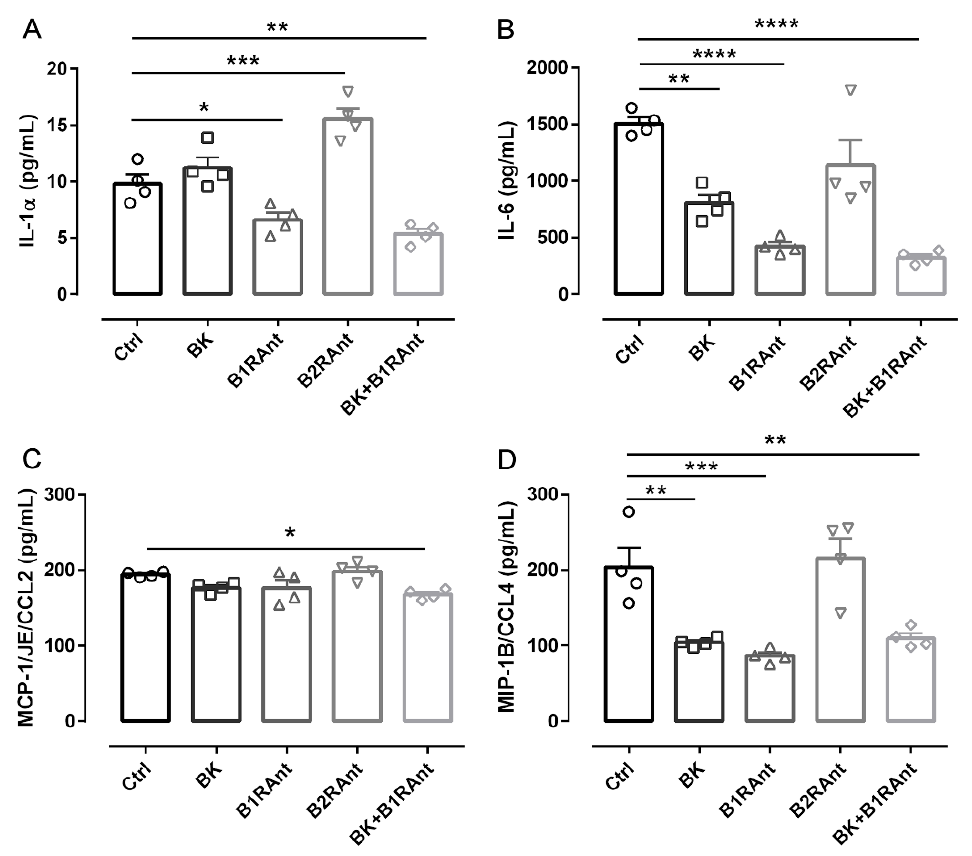
Figure 6. B1 and B2 receptors modulate inflammation in Alzheimer’s disease. Hippocampal slices from 12-month-old TG animals after 20 DIV of treatment with 300 pM bradykinin and / or 200 pM B1R antagonist or 300 pM B2R antagonist. The culture medium was collected and the level of cytokines, ( A ) IL-1a, ( B ) IL-6, ( C ) MCP-1 / JE / CCL2 and ( D ) MIP-1B / CCL4, was evaluated using the Elisa Multiplex method with the Luminex 200 system. NT—untreated slices; BK—bradykinin 300 pM; B1RAnt—[des-Arg10]-HOE 140 200 pM; B2RAnt—Bradyzide 300 pM; * p < 0.05; ** p < 0.01; *** p < 0.001; **** p < 0.0001. Data were analyzed with one-way ANOVA followed by Dunnett’s multiple comparison test. Technical quadruplicate of biological samples of four animals were used for each treatment.